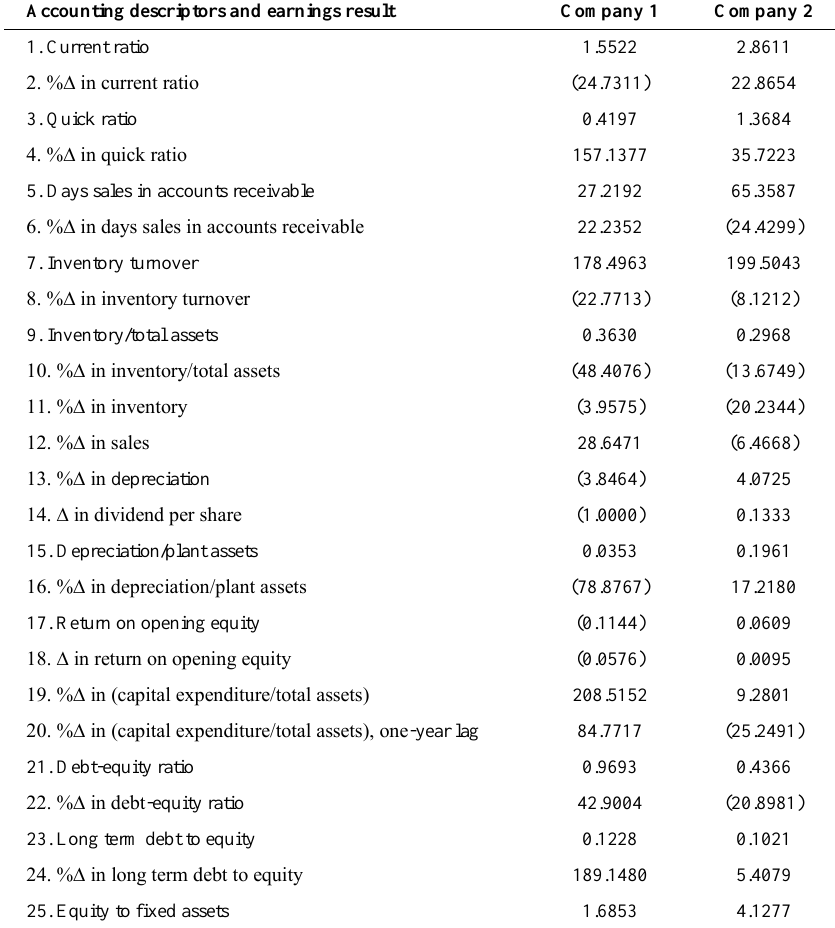
Table 2. Example of descriptor variables and earnings results from two